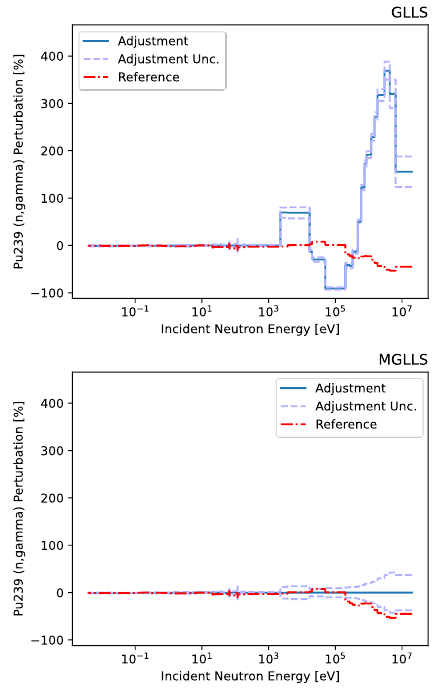
Fig. 8 Comparison of adjusted nuclear data #7